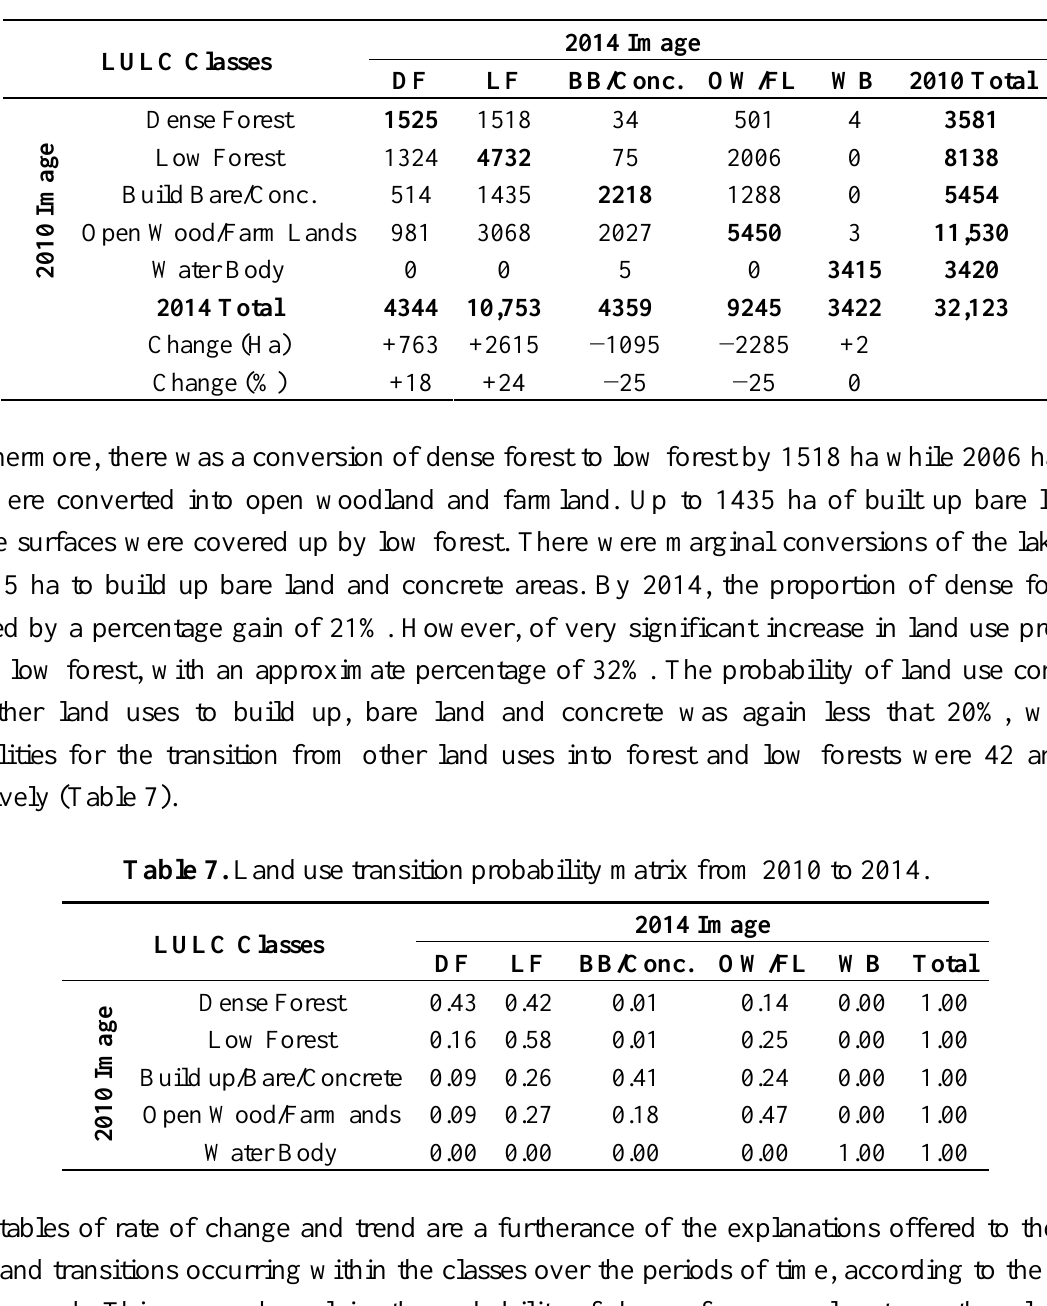
Table 6. Land use class transition matrix from 2010 to 2014.